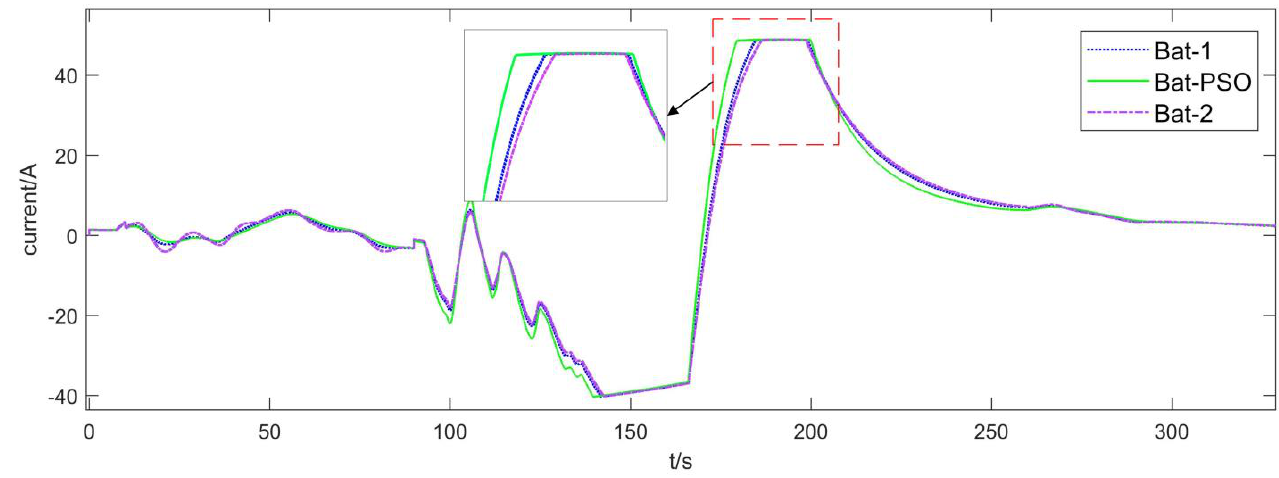
Figure 10. Supercapacitor output current under different energy management policy parameters.